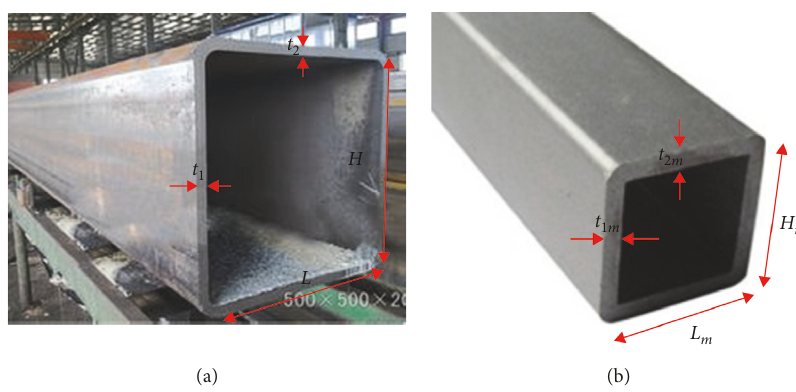
Figure 2: Cross-sectional shape of the leg. (a) Prototype. (b) Similarity model. Table 2: Cross-sectional parameters of landside leg 2. Design Item